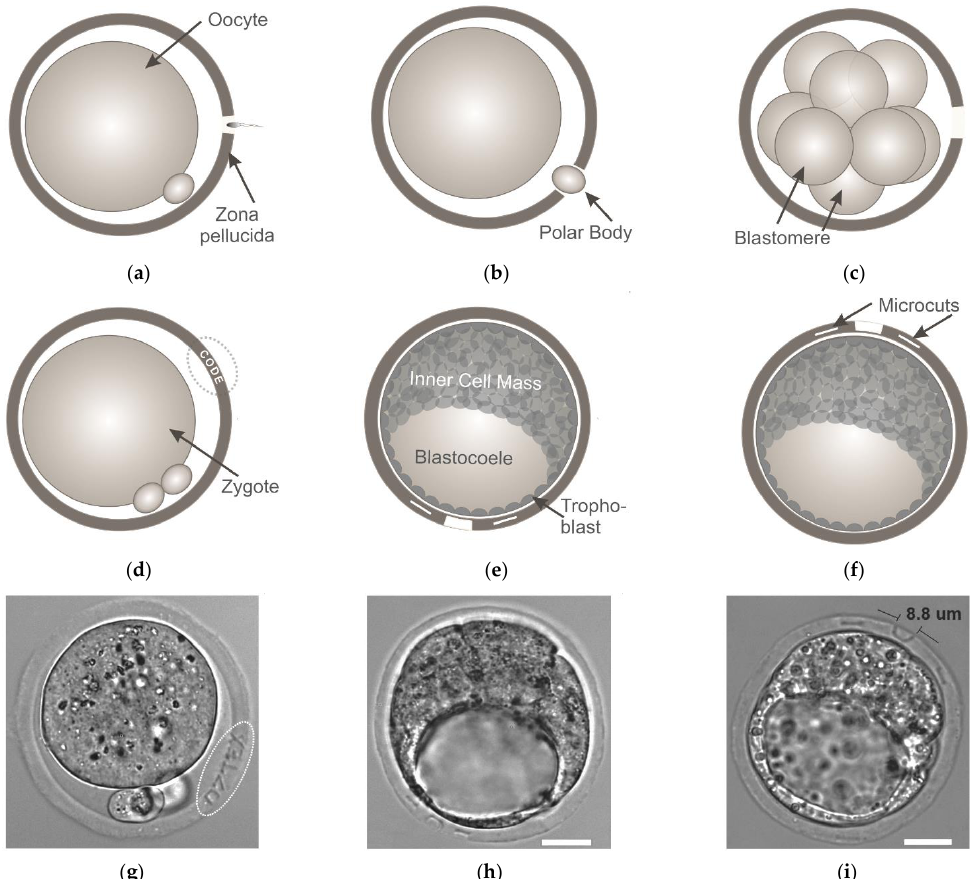
Figure 2. Laser-based ZP microsurgery for applications in ART includes ( a ) in vitro fertilization, ( b ) polar body biopsy, ( c ) laser-assisted hatching; ( d – i ) novel techniques based on ZP microsurgery with femtosecond laser pulses (mouse embryos were used in the experiments): ( d ) individual laser-assisted embryo labeling by creating an alphanumerical code on the ZP’s volume and ( g ) example of code “07TEX” engraved on the zygote’s ZP (the dashed circles highlight the codes), ( e , f ) controlled laser-assisted hatching at the prescribed location by ZP microsurgery at the blastocyst stage either close to the TE ( e,h ) or the ICM ( f , i ). Scale bar 20 µm.